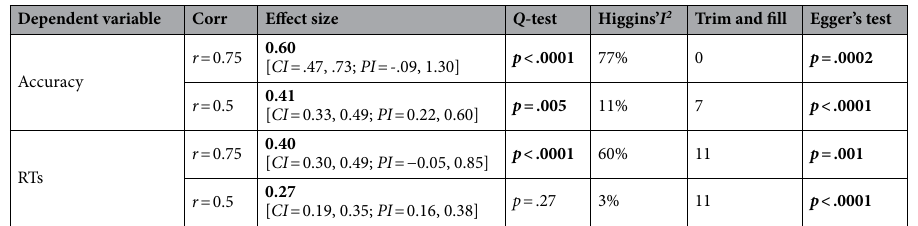
Table 5. Results of the meta-analyses performed with the effect sizes of the within-participants studies included computed using r = 0.75 or r = 0.5.